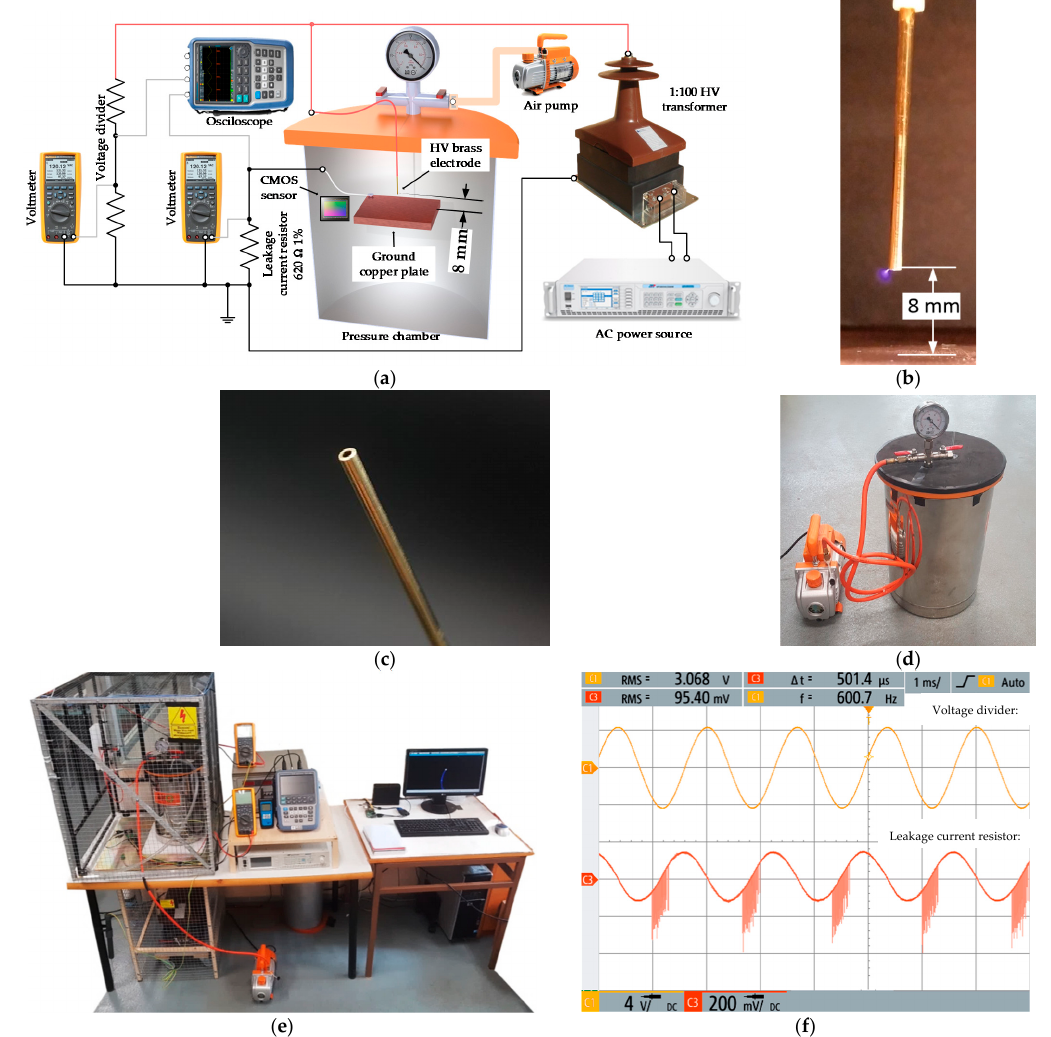
Figure 1. Experimental setup. ( a ) Sketch of the experimental setup and the instrumentation used in the high-voltage tests at variable pressure, frequency and voltage; ( b ) photograph of the rod-to-plane electrode used in the experiments; ( c ) detail of the tip of the electrode; ( d ) low-pressure chamber; ( e ) photograph of the experimental setup including the low-pressure chamber; ( f ) snapshot of the oscilloscope used to detect corona activity connected to the terminals of the leakage current resistor.